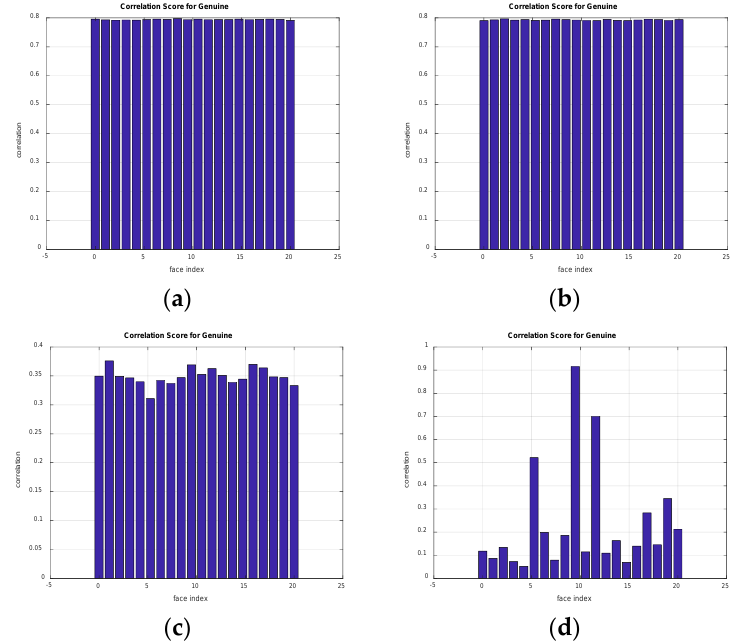
Figure 18. Correlation scores for unauthorised imposter patterns (for FERET dataset) for ( a ) CFR1, ( b ) CFR2, ( c ) homomorphic transform followed by salting and ( d ) homomorphic transform followed by random kernel convolution.